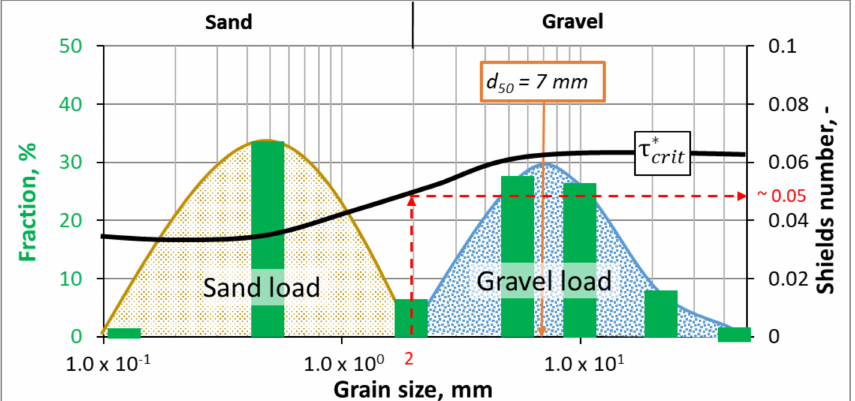
Figure 2. The density function of a bed material sample collected from a side bar (green curve). The Shields curve-related critical bed shear stress values are depicted by the black